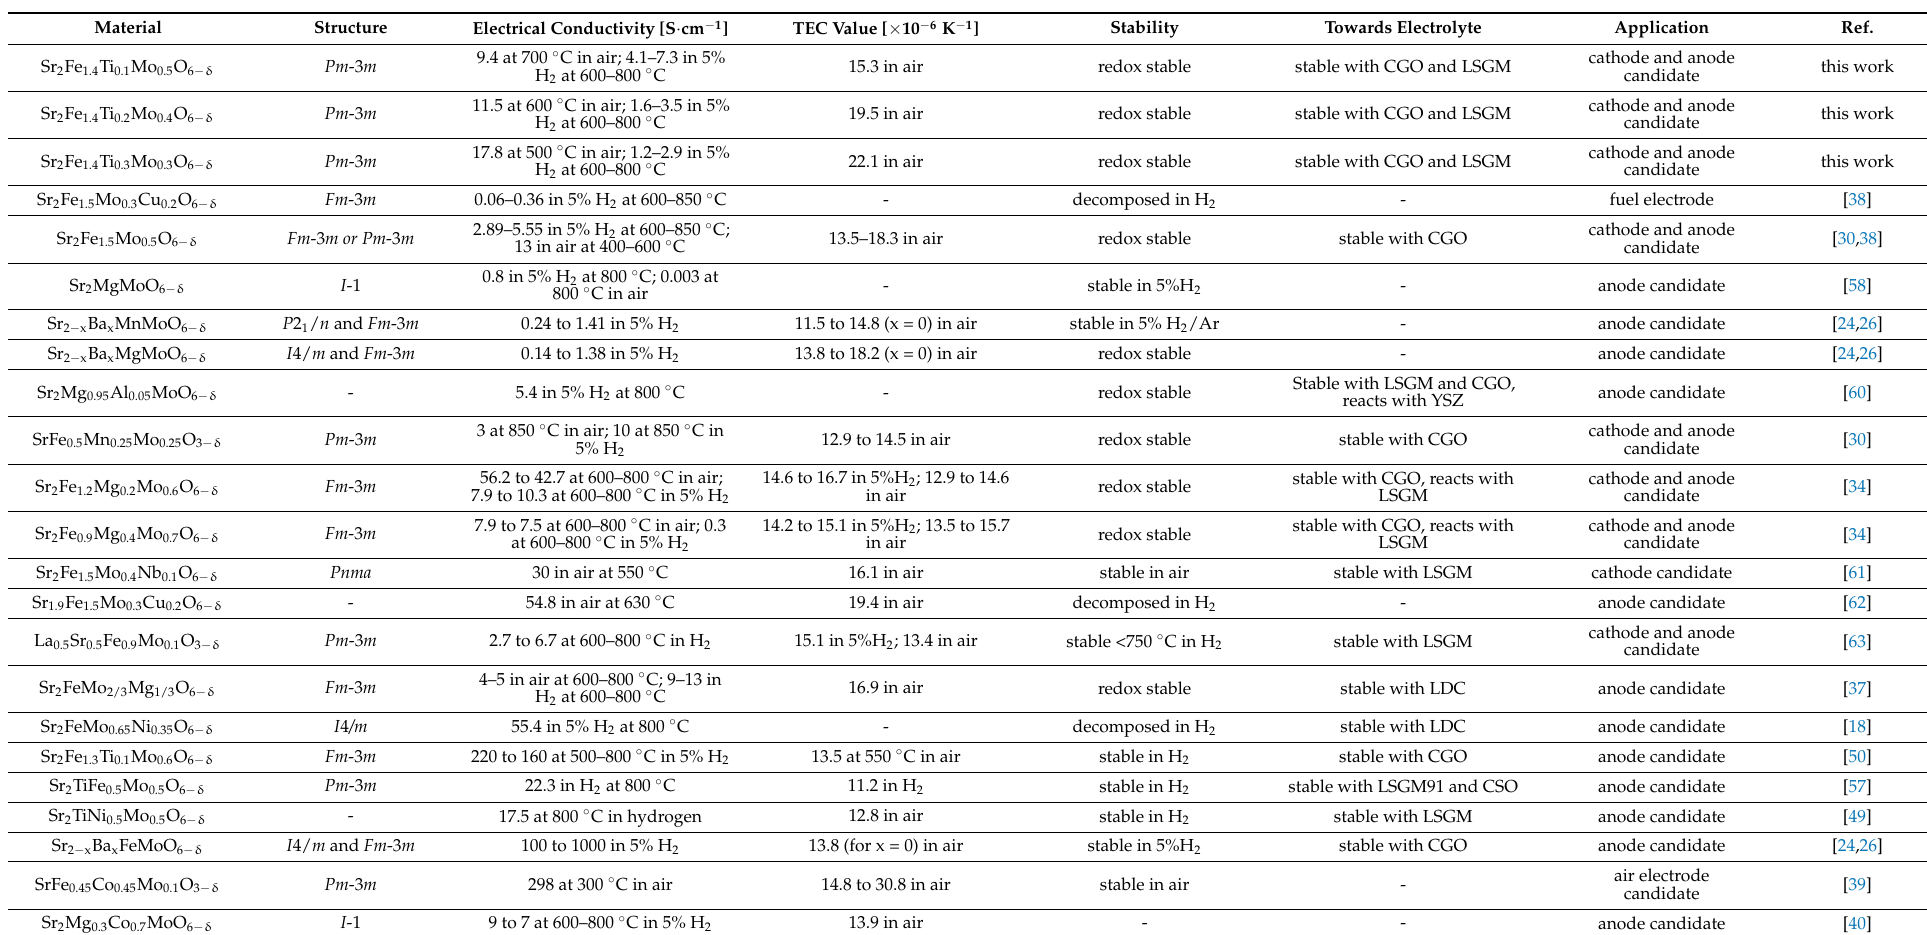
Table 3. The crystal structure, electrical conductivity, thermal expansion coefficient (TEC), redox stability and compatibility with electrolytes, as well as the application of Sr 2 (Fe,Mo)O 6 − δ -based